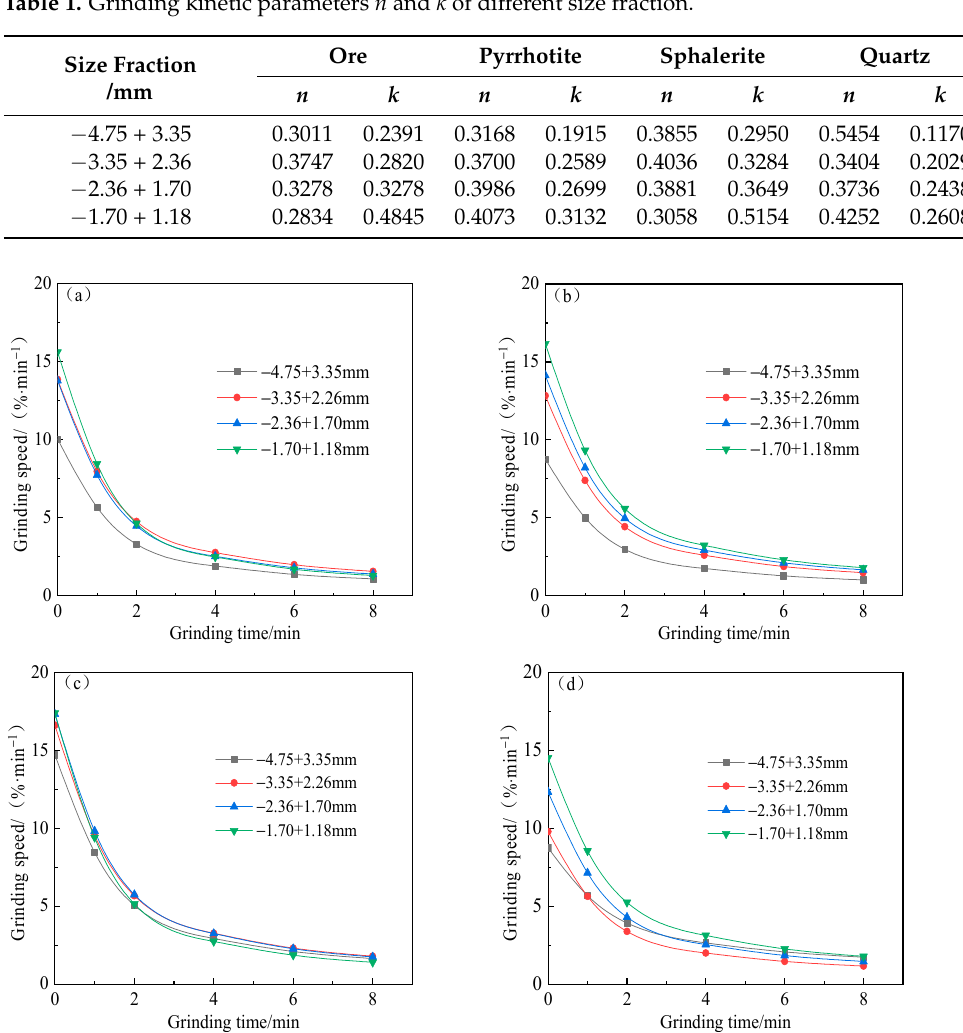
Figure 5. The relationship between grinding speed of materials and grinding time at different feed sizes ( a ) Ore, ( b ) Pyrrhotite, ( c ) Sphalerite, ( d ) sizes ( a ) Ore, ( b ) Pyrrhotite, ( c ) Sphalerite, ( d ) Quartz.